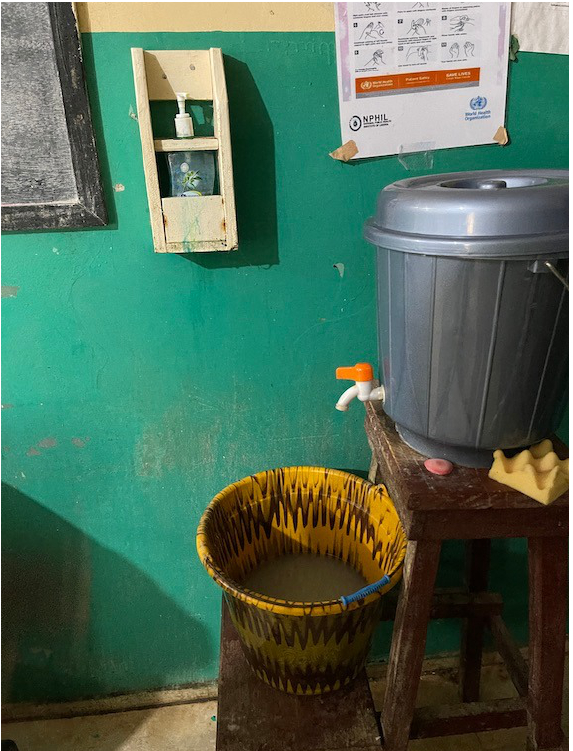
Figure 1. Handwashing station and wall-mounted hand sanitizer dispenser in Liberian health facility, 2020 (photo courtesy of the